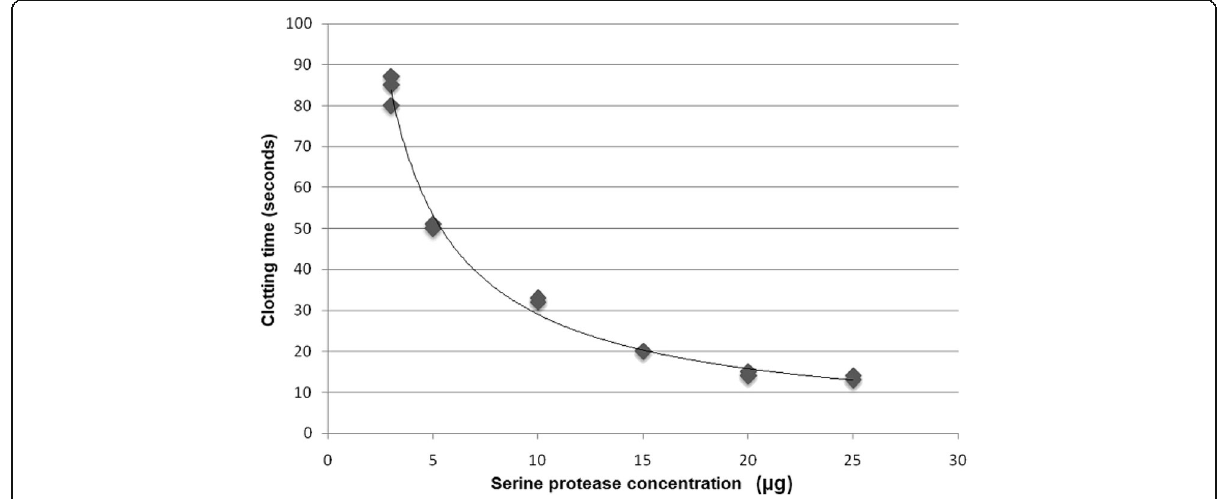
Fig. 9 Evaluation at pH 7.4 of the minimum coagulant dose (MCD) of the serine protease by potential regression analysis y = 220.13x -0,879 , R 2 =